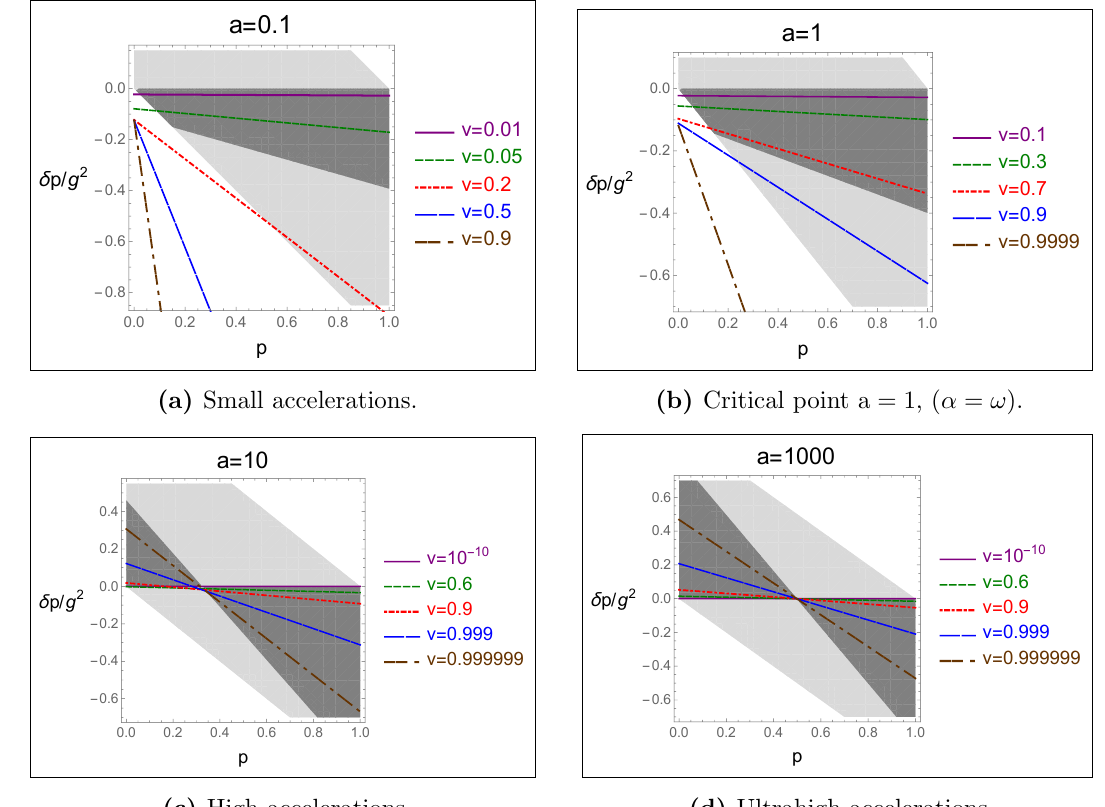
Figure 5. Behavior of the corrections of the excited state population (cid:14)p , in units of g 2 , as function of its initial population, p , for di(cid:11)erent accelerations and velocities. The lighter gray area indicates corrections that obey 0 < p + (cid:14)p < 1, where g = 1 has been considered. The darker gray area indicates points where the perturbative regime is satis(cid:12)ed, ie. j (cid:14)p j (cid:28) p